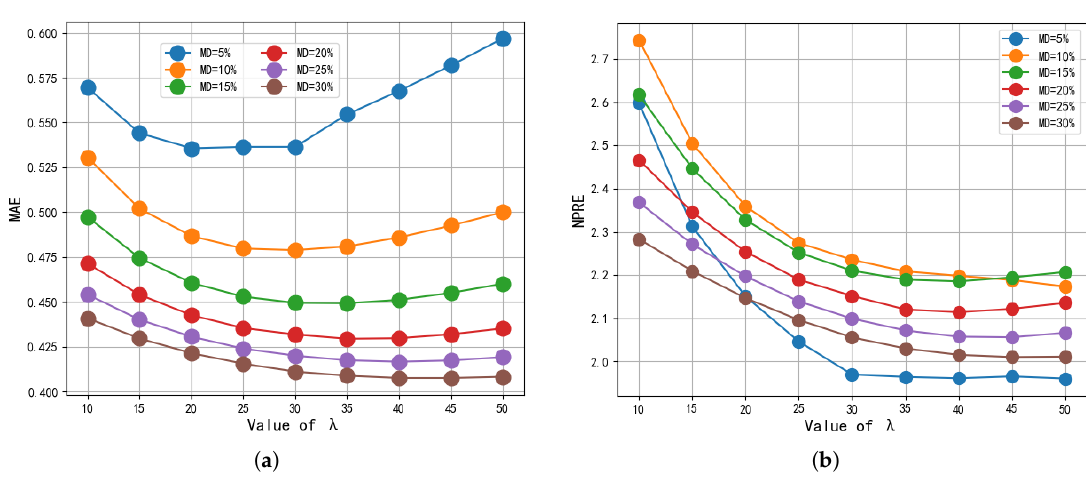
Figure 3. Impact of λ U and λ S . ( a ) MAE; ( b )